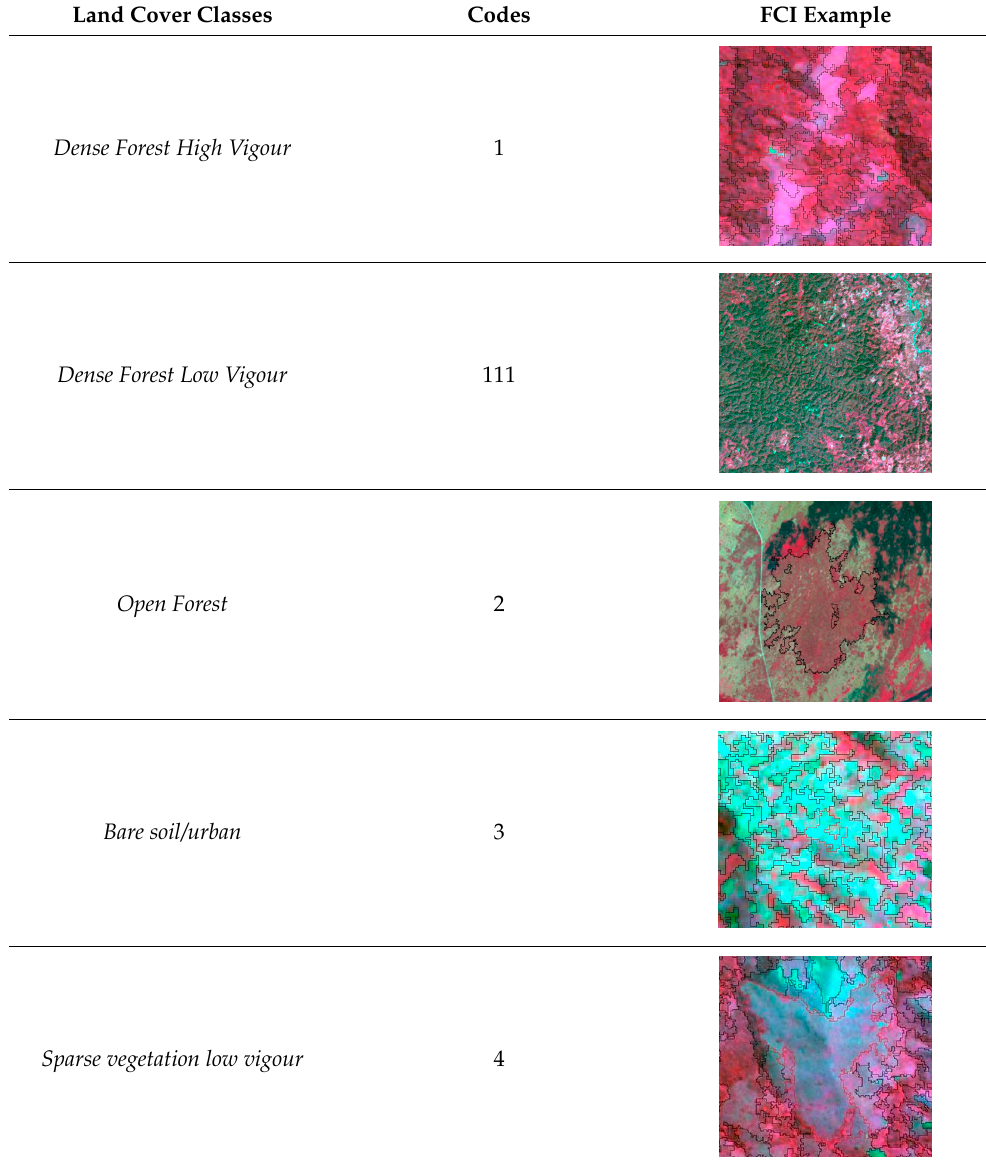
Table A1. False-colour image (FCI) from mosaicked S2 bands, used to create thirteen land cover classes used in turns to define Regions of Interest.